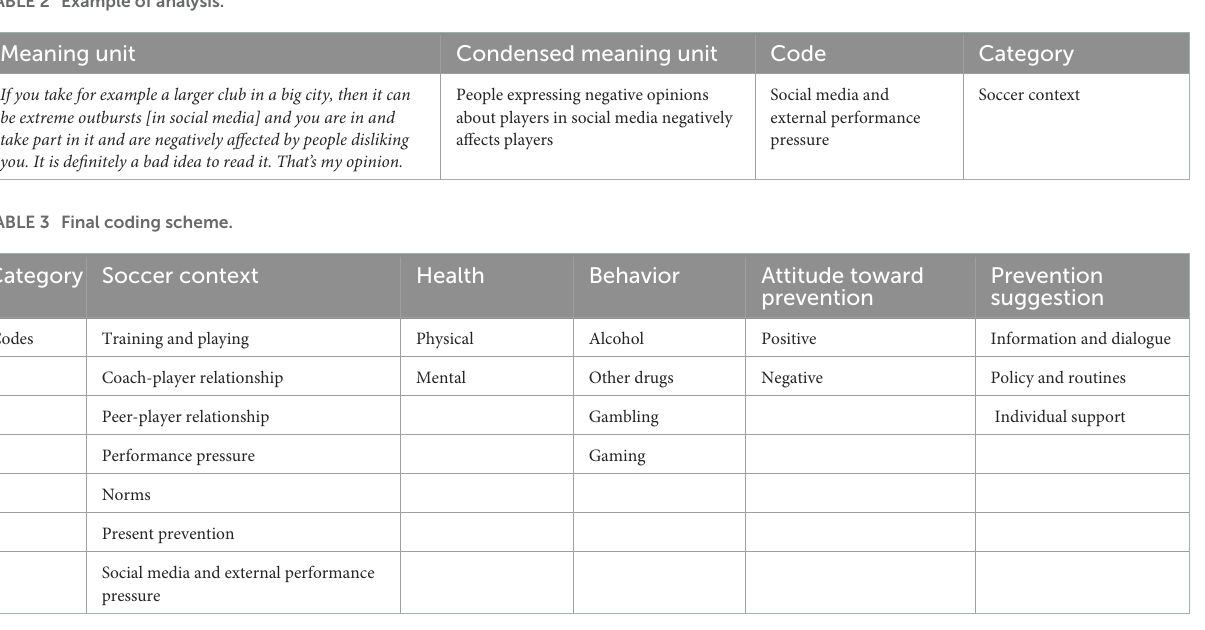
TABLE 2 Example of analysis.